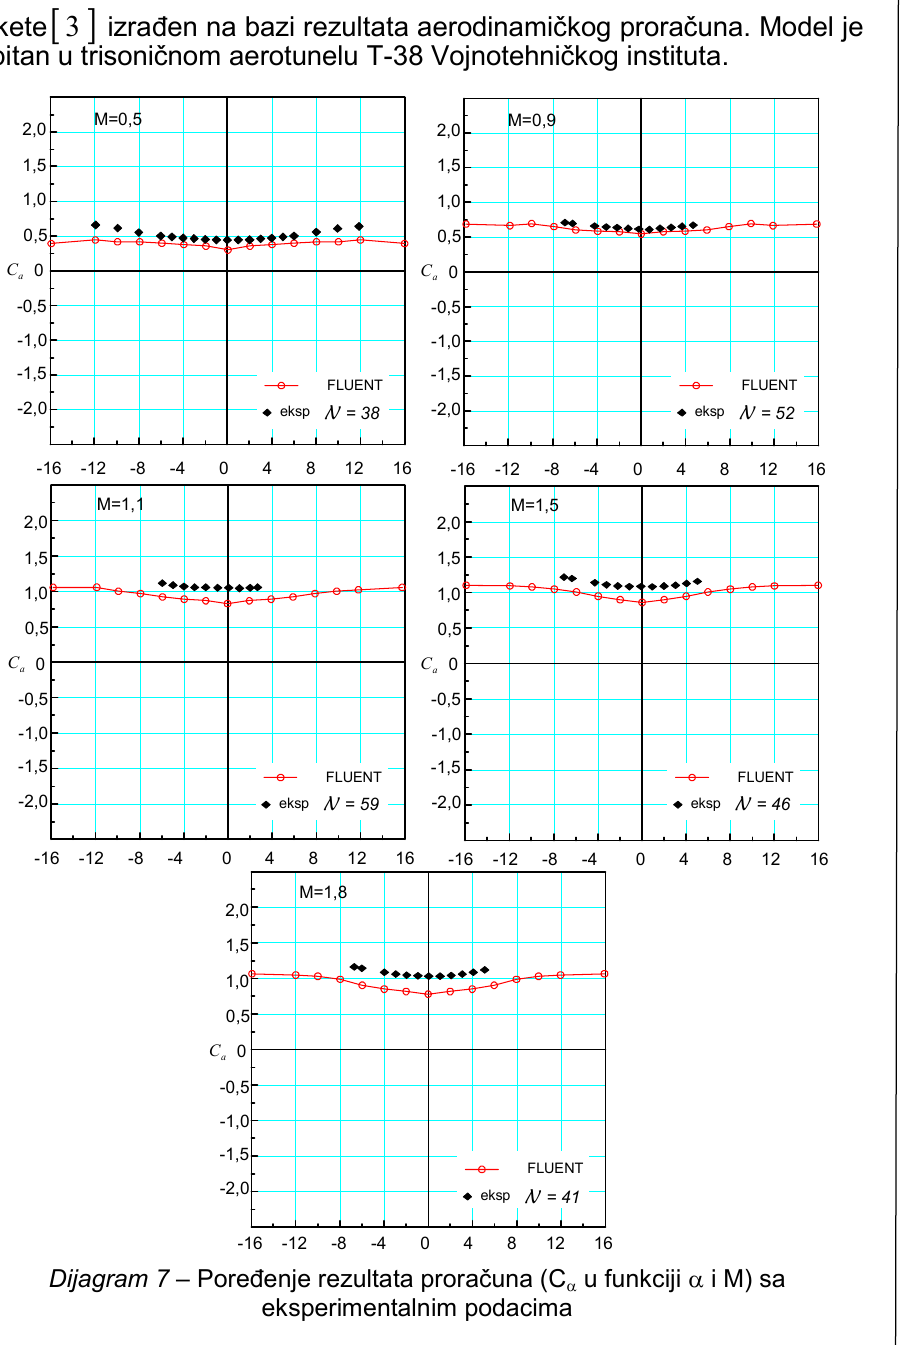
eksperimentalnim